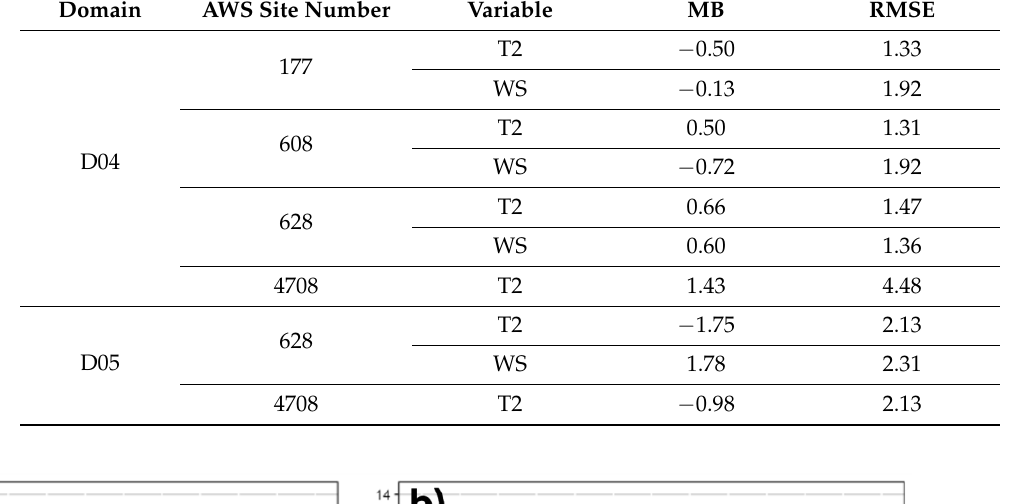
Table 3. Performance of WRF–LES simulation for Case 1.